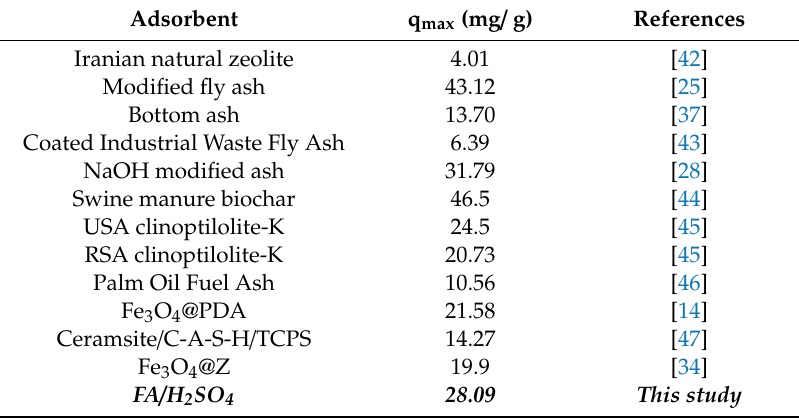
Table 5. Comparison of maximum Cd 2 + adsorption capacities (q max ) of di ff erent adsorbents reported in